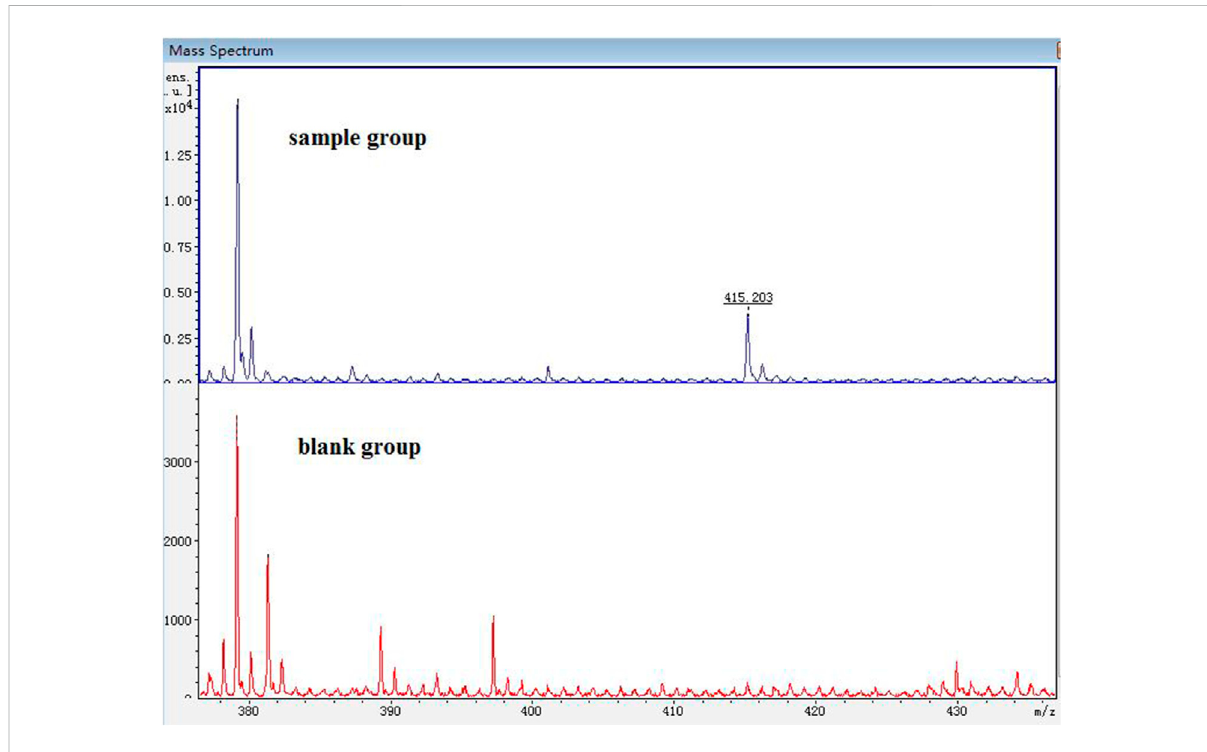
FIGURE 2 MALDI-TOF MS of the mice plasma dosed with D1 (sample group) or without D1 (blank group).